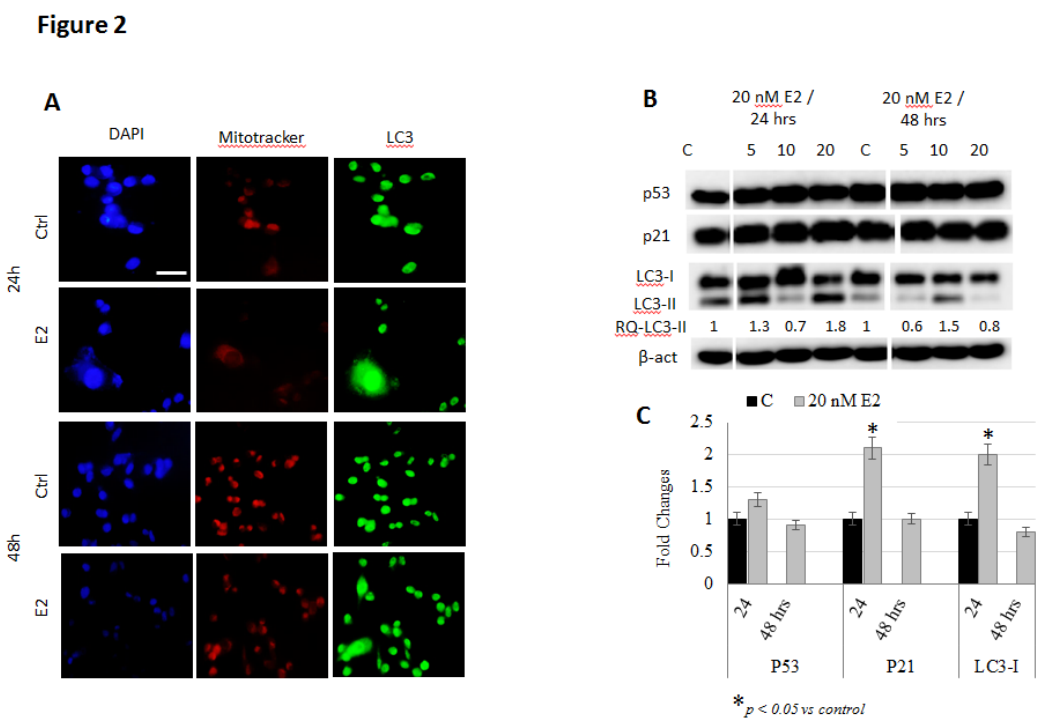
Figure 2. Mitochondrial accumulation and autophagy in E2-treated MDA-MB-231 cells. ( A ) Cells treated with 20 nM E2 or left untreated for 24 or 48 h were stained for DNA (DAPI; blue), mitochondrial accumulation (mitotracker; red) and LC3 (green); images were taken at 40X magnification; scale bar (white) represents 10 µ m. Presence of SAHF (senescence-associated heterochromatin foci) in the nuclear region of senescent cells is indicated by white arrows. ( B ) Expression of cell senescence and autophagy markers P53, P21 and LC3-I/II in lysates of cells treated with 20 nM E2 for 24 and 48 h; RQ refer to LC3-II quantity under different treatment conditions relative to control. ( C ) Mean + SD fold change in protein expression in treated and untreated cells based on three separate experiments.